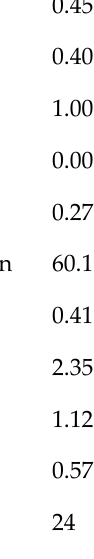
Figure 2. The histogram of the normalized sustainable economic competitiveness index ( SECI (cid:48) ).